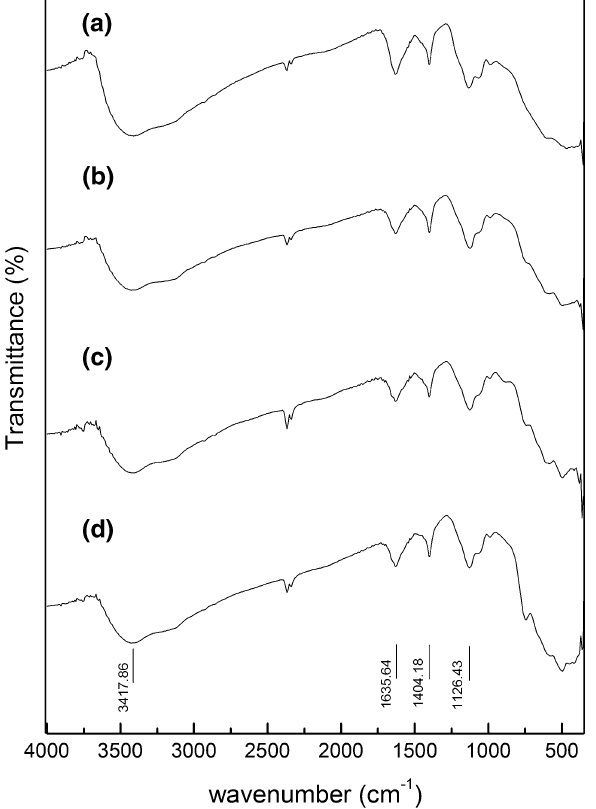
Fig. 3 FTIR spectra of sulfated zirconia under different calcination temperatures: a 400 (cid:3) C, b 500 (cid:3) C, c 600 (cid:3) C, and d 700 (cid:3)